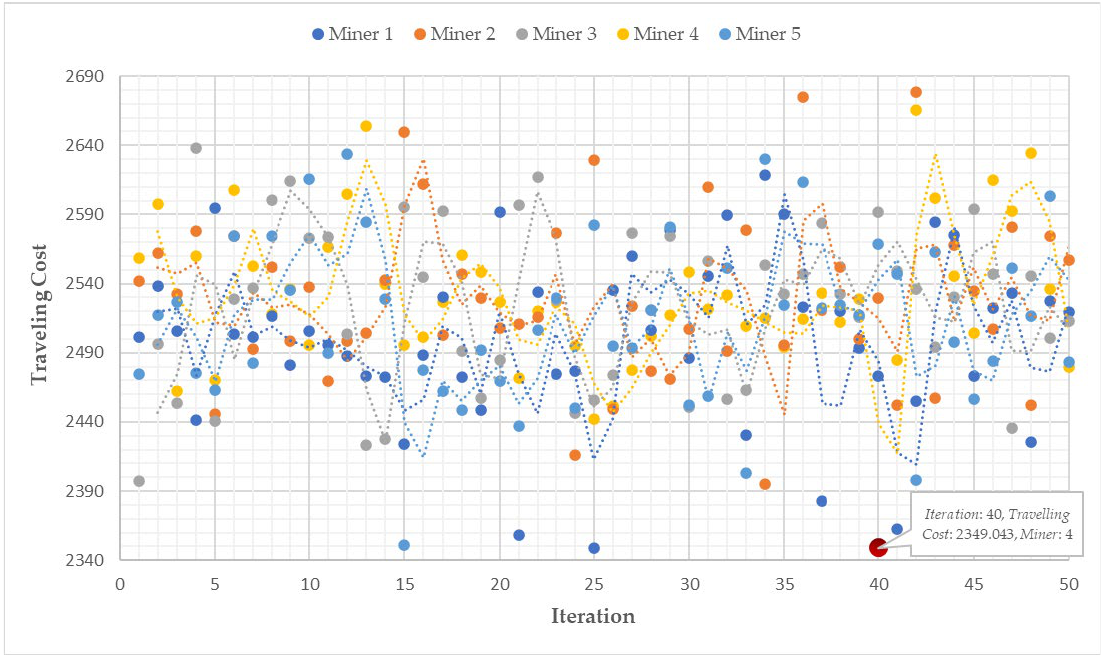
Figure 17. Collaboration of miners to determine the appropriate solution for the traveling salesman problem in the entire search space (the number of cities was 500).